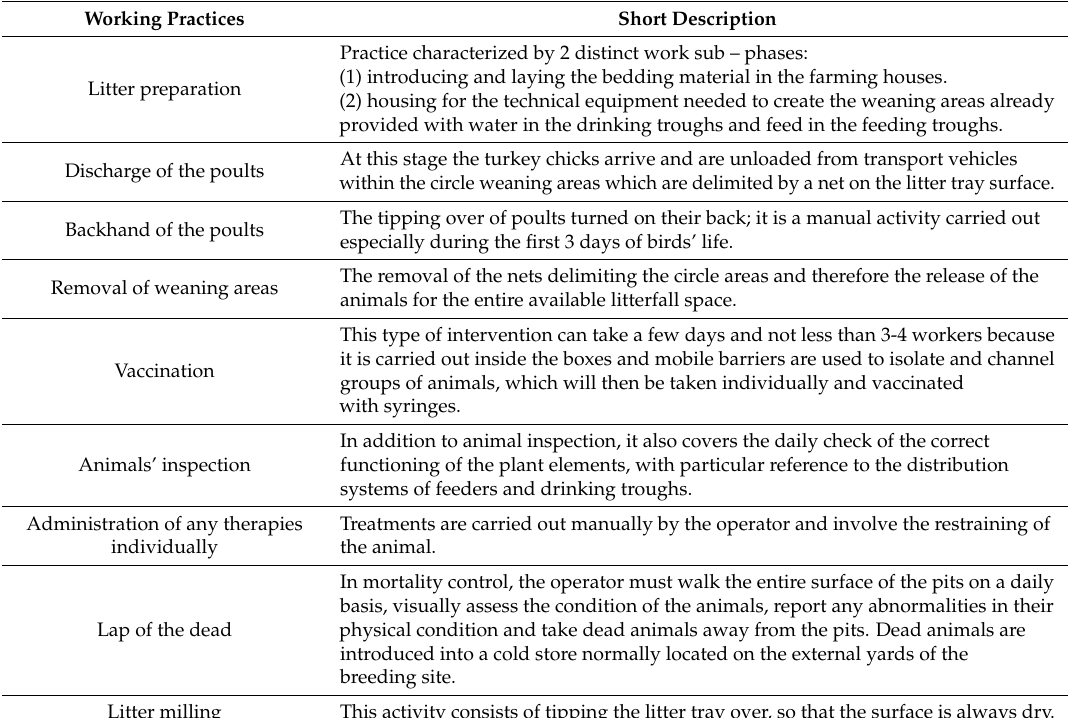
Table 6. List of the main working practices in turkey farming, as obtained through semi-structured interviews to key informants, in Northern